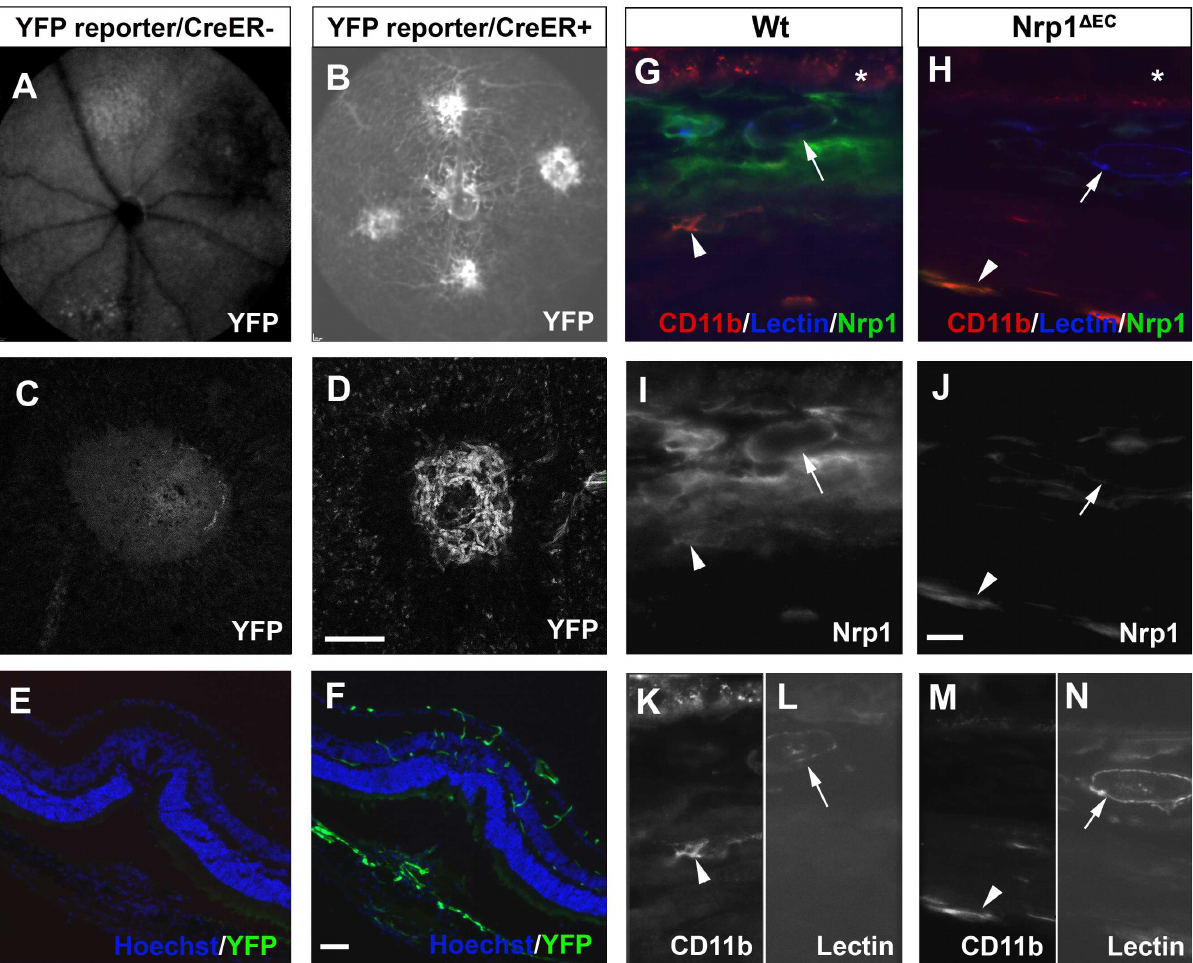
Fig 1. Confirmation of Cre recombinase activity and Nrp1 deletion in the choroidal vasculature. A YFP reporter strain (A-F) was used to demonstrate recombination activity in animalscarrying the tamoxifen-inducibletransgene Pdgfb-CreER(B, D, F). CreER negativeanimals were used as a negativecontrol (A, C, E). In vivo imaging(A, B) using the fluorescein channelin a Spectralisophthalmoscope focused on the choroid showedYFP expressionin most vessels, includinglaser-induced neovascularfoci. Microscopy on postmortemtissue also demonstrates pronounced YFP fluorescence in laser-inducedCNV lesions in choroidal flatmounts(C, D), and in cross sections (E, F) showingHoechst staining(blue) and YFP fluorescence (green). Microscopy on cross sectionsfrom the choroidfrom Nrp1 Δ EC mice (H, J, M, N) or wild type controls (G, I, K, L) was used to demonstrate deletionof Nrp1 from endothelial cells (white arrows) by immunohistochemistry against Nrp1 (green in G, H, white in I, J). Nrp1 expressedby microglia(arrowheads), stainedwith anti-CD11b(red in G, H, white in K, M), was not targeted (I, J). Asterisks in G, H indicateautofluorescent RPR. Scale bars in D, F are 100 μ m and in J 10 μ